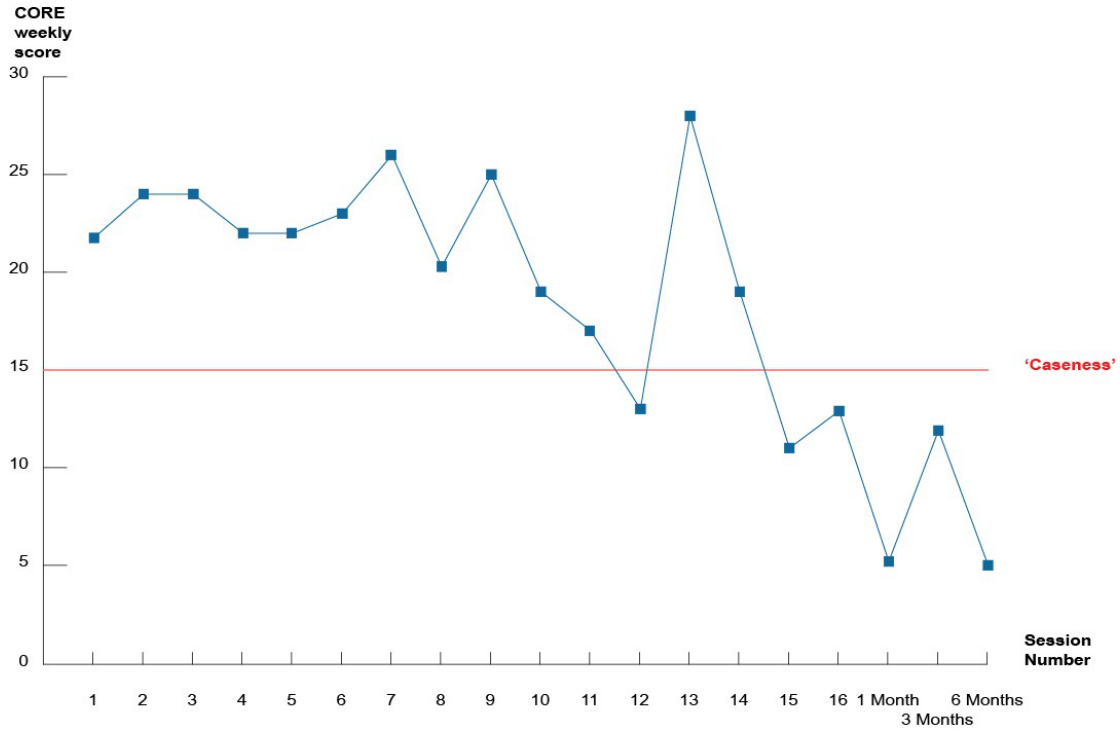
Figure 1. Weekly CORE-10 scores